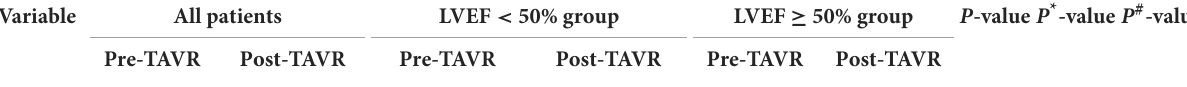
TABLE 4 The comparison of NT-proBNP at baseline and the end of the study. Variable